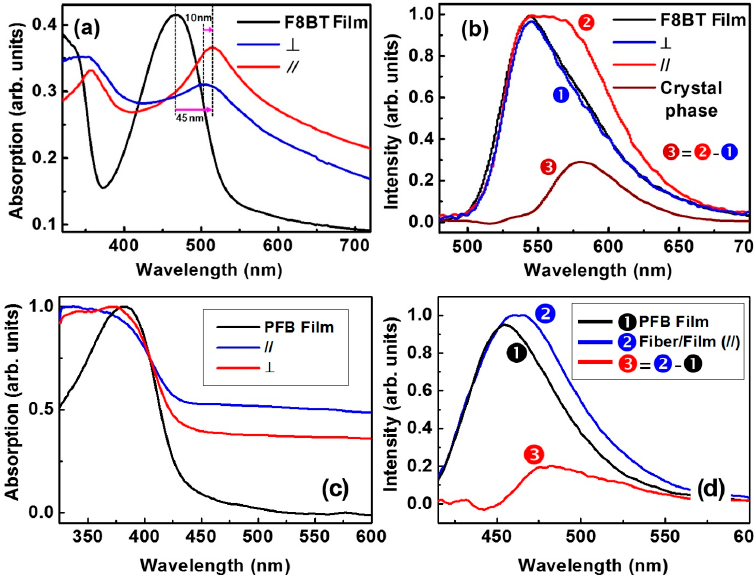
Figure 5. ( a ) Absorption spectra of the spin-coated F8BT film (black) and the F8BT fibers for light polarized perpendicular (blue) and parallel (red) to the grating lines; ( b ) The corresponding PL spectra for the sample in ( a ); ( c ) Absorption spectra of the spin-coated PFB film (black) and the PFB fibers for light polarized perpendicular (red) and parallel (blue) to the grating lines; and ( d ) The PL spectra measured on the PFB film (black), PFB fibers at a parallel polarization direction (blue), and the difference between them (red).